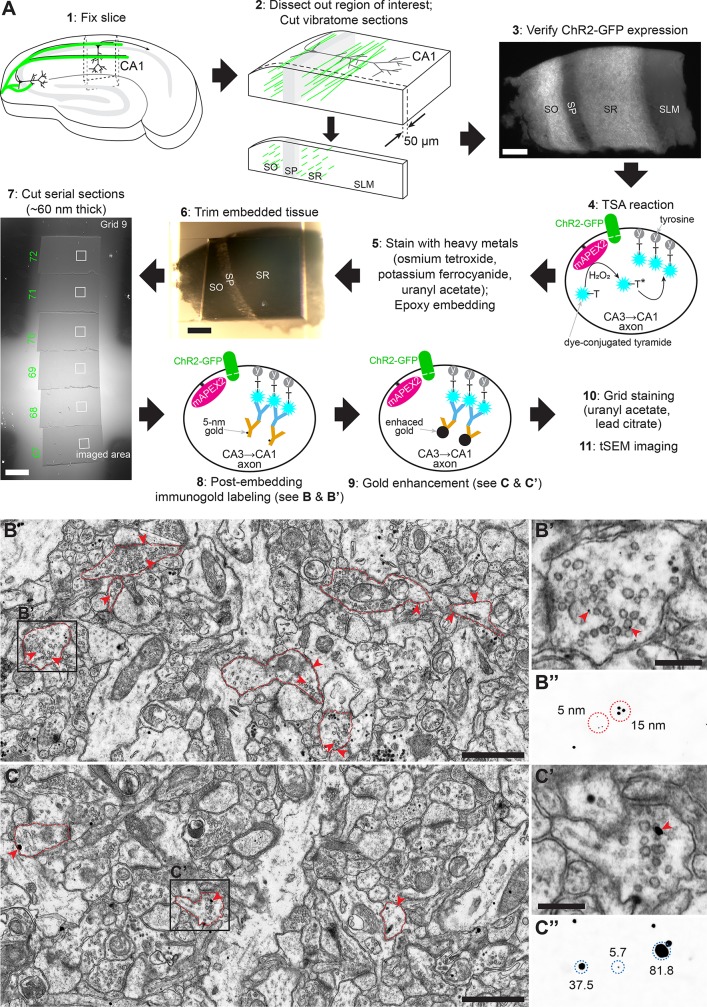
mAPEX2-catalyzed labeling and 3DEM identification of rAAV-targeted axons.(A) Workflow for processing of hippocampal slices following optical L-LTP. Vibratome sections from the fixed area CA1 underwent tyramide signal amplification (TSA) catalyzed by mAPEX2 to deposit Alexa Fluor dye in the targeted axons. The dye-labeled section was then stained with heavy metals and embedded into epoxy before being cut into serial thin sections. The dye-containing axons in a subset of the sections were immunolabeled with 5 nm gold particles, followed by gold enhancement. Scale bars = 100 μm. (B and B’) A low magnification tSEM image of the area CA1 stratum radiatum after immunolabeling (Step 8 in A). Axonal boutons indicated by red contours were positively labeled with 5 nm gold particles (red arrowheads). Area indicated by black rectangle is enlarged in B’. Scale bar = 1 μm in B, 250 nm in B’. (B”) A tSEM image of colloidal gold particles (5 nm and 15 nm). To visualize the 5 nm particles more clearly, this image was acquired at 1 nm/pixel and scaled to the same magnification as B’. (C and C’) Same as B and B’, imaged after gold enhancement (Step 9 in A). Scale bar = 1 μm in C, 250 nm in C’. (C”) A tSEM image of enhanced gold particles. The numbers indicate diameters in nm (also see S5 Fig).